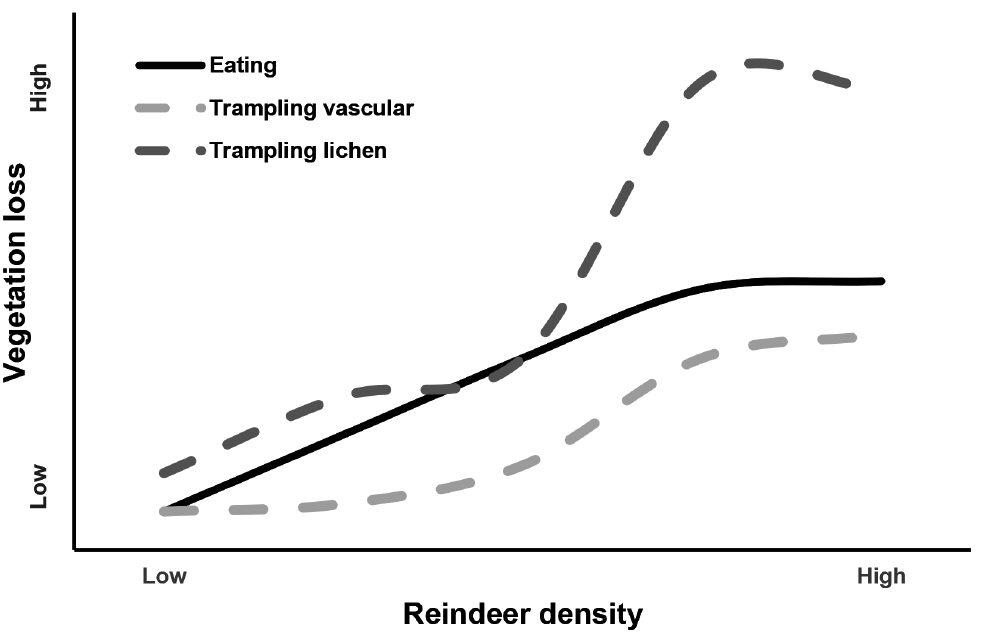
Figure 1. A conceptual model of vegetation loss due to eating and trampling by reindeer. Trampling generates more vegetation loss than eating, but the relationship is likely underestimated in the figure (illustration purposes). A near linear relationship may exist for plant eating (black line) and reindeer density when forage is abundant, but decreasing as competition for food increases, and depending on annual production of forage. Trampling loss may be low at low reindeer densities for pliable vascular plants (light grey darted line), but likely more linear in lichen (dark grey darted line), in particular in dry lichen, and considerably more than vegetation eaten. Step overlap may perhaps initially decrease loss rate of lichen as reindeer density increases. Loss will increase until vegetation cover is reduced, and eventually approaches mechanical disruption, when loss will obviously drop sharply (not modelled